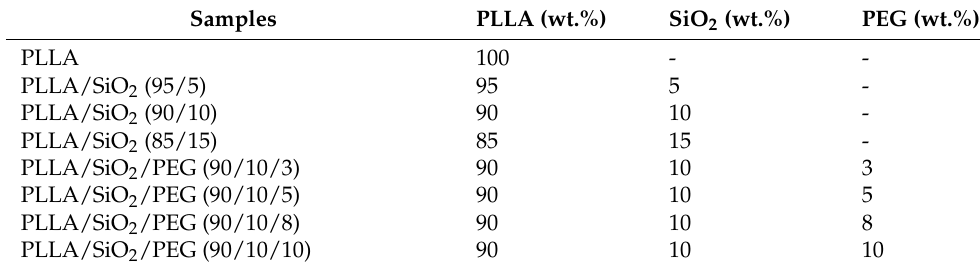
Table 4. Formulations for the